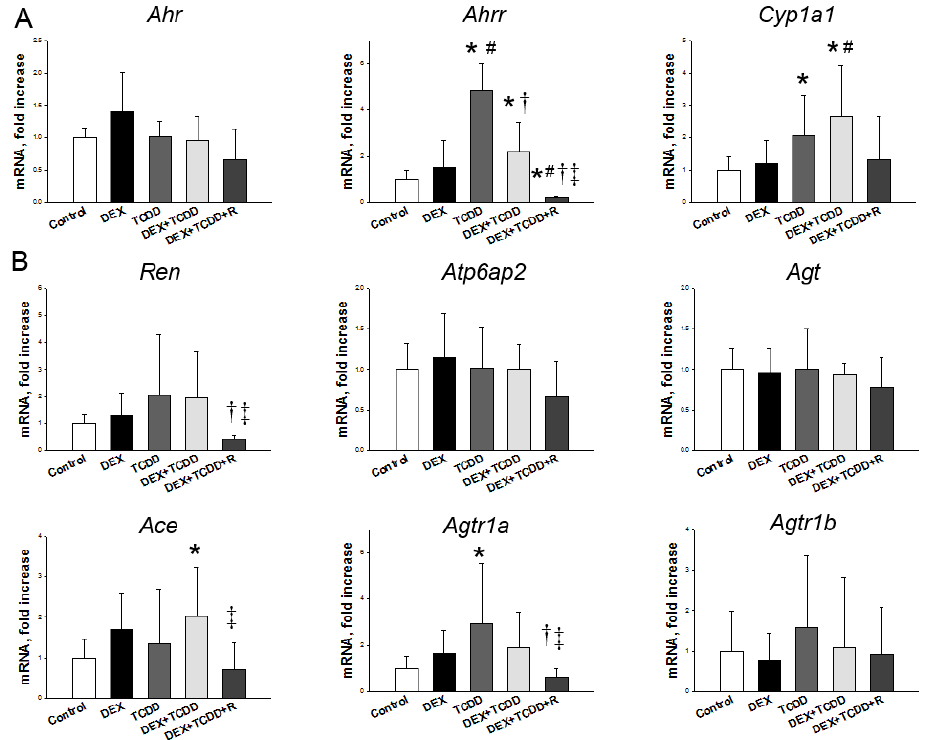
Figure 3. Effects of maternal 2,3,7,8-tetrachlorodibenzo-p-dioxin (TCDD), prenatal dexamethasone (DEX), and resveratrol (R) on mRNA expression of ( A ) aryl hydrocarbon receptor (AHR) signaling pathway, including Ahr , Ahrr , and Cyp1a1 ; and ( B ) components of renin–angiotensin system (RAS), including Ren , Atp6ap2 , Agt , Ace , Agtr1a , and Agtr1b in male offspring kidneys at 16 weeks of age. Data were analyzed by one-way ANOVA followed by Dunnett’s C post hoc test. * p < 0.05 versus control group; # p < 0.05 versus DEX group; † p < 0.05 versus TCDD group; ‡ p < 0.05 versus DEX +